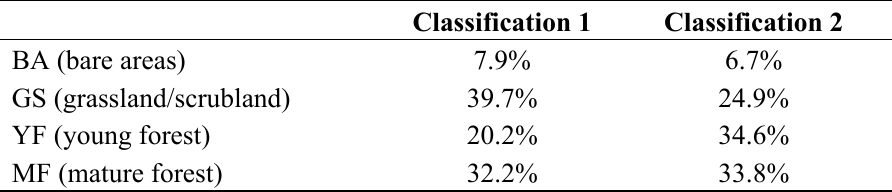
Table 1. Percentages of the study region under each land cover class: Classification 1 was based on the spectral reflectance and the topographic data, while Classification 2 also included texture